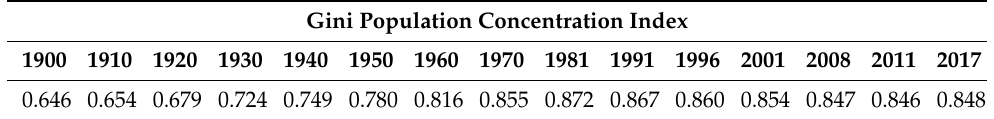
Table 12. Gini population concentration index by municipality in Catalonia (1900–2017). Source: